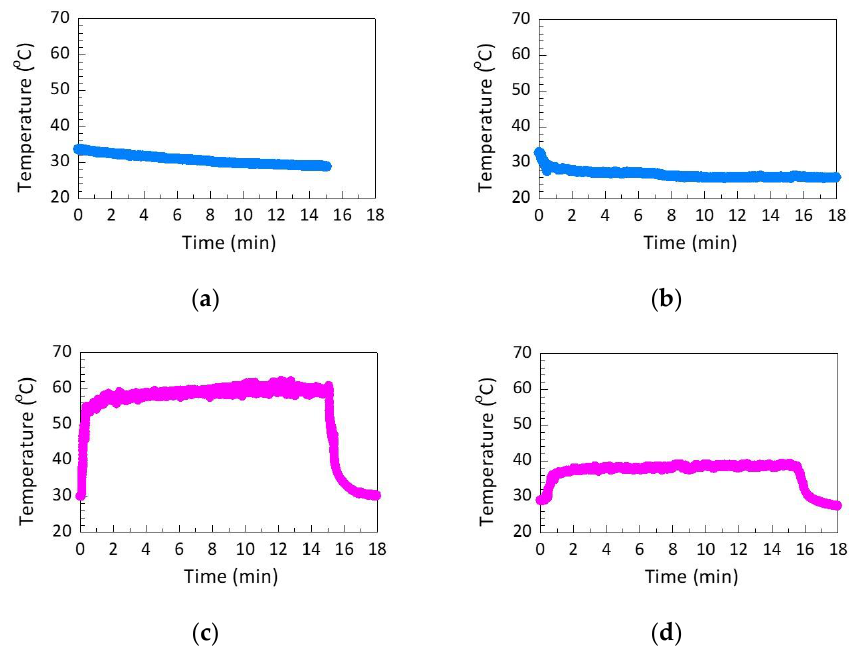
Figure 3. Thermal images taken on live mice ( a ) before treatment, ( b ) during He gas flow treatment at 15 min, ( c ) during contact plasma treatment at 15 min, and ( d ) during non-contact plasma treat- ment at 15 min.